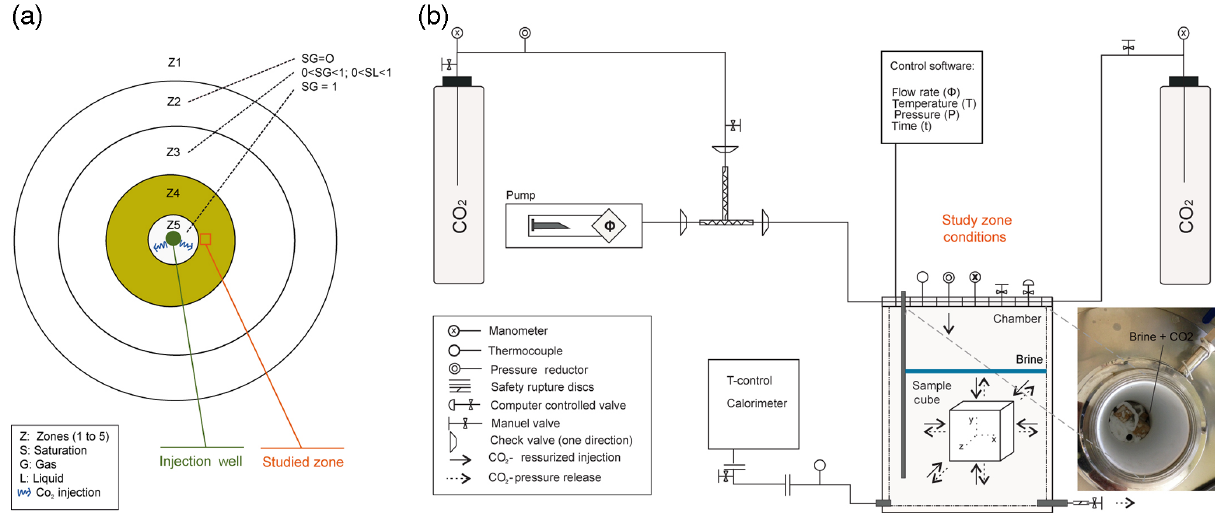
Figure 1. (a) Conceptual diagram of the reactive zones (Z1, Z2, Z3, Z4 and Z5) around the injection well according to André et al. (2007) and Gaus et al. (2008). Zone 1: zone not affected by CO 2 injection; Zone 2: acidified zone with dissolution and precipitation of minerals. Zone 3: Dissolution and precipitation of minerals (e.g. calcite and dolomite) and highly buffered pH. Zone 4: Highly saline water and salt precipitation (e.g. NaCl and Ma 2 SO 4 ) . Zone 5: Dehydration reactions in open systems. (b) Layout of the experimental setup. Reactor system used for the pressurized CO 2 injection (modified from Berrezueta et al.,